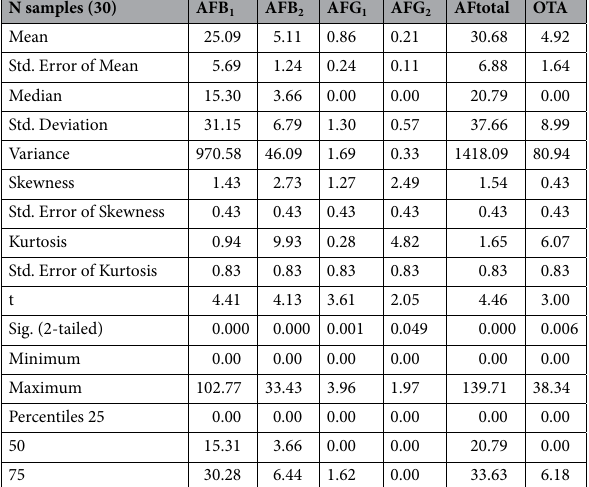
Table 11. Statistical summary of data obtained from the Central Region of Ghana.